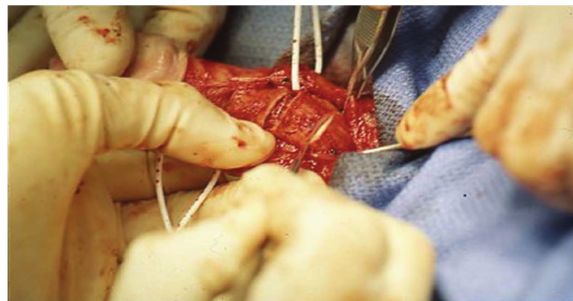
Figure 3: With the neurovascular bundles retracted laterally by the vessel loops, an H-incision is made at the point of maximal